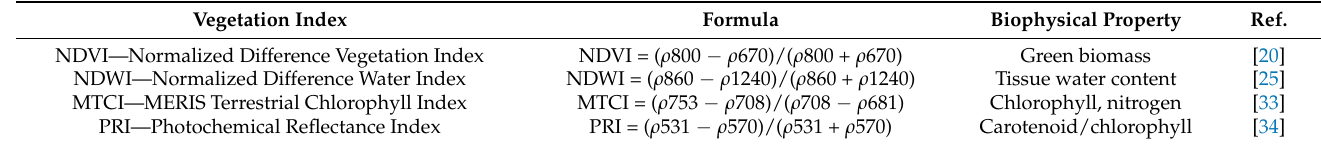
Table 1. Vegetation indices used in this study with their formulation and biophysical properties repre- sented according to the literature. ρ indicates the reflectance of the vegetation in the reported wavelength. Vegetation Index Formula Biophysical Property